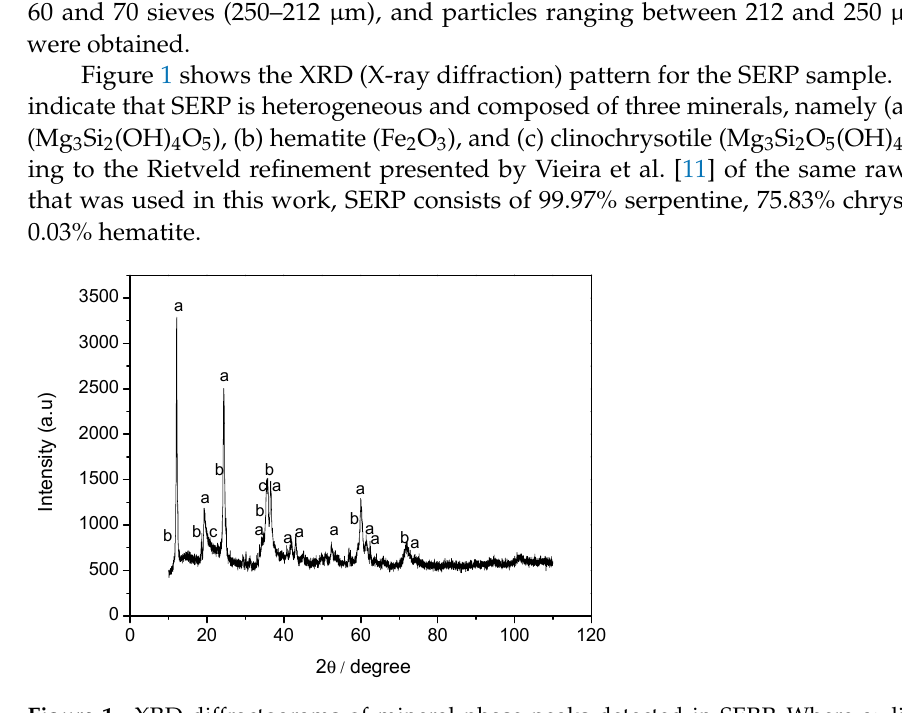
Figure 1. XRD diffractograms of mineral phase peaks detected in SERP. Where a: lizardite 1T, b: hematite and c: clinochrysotile.